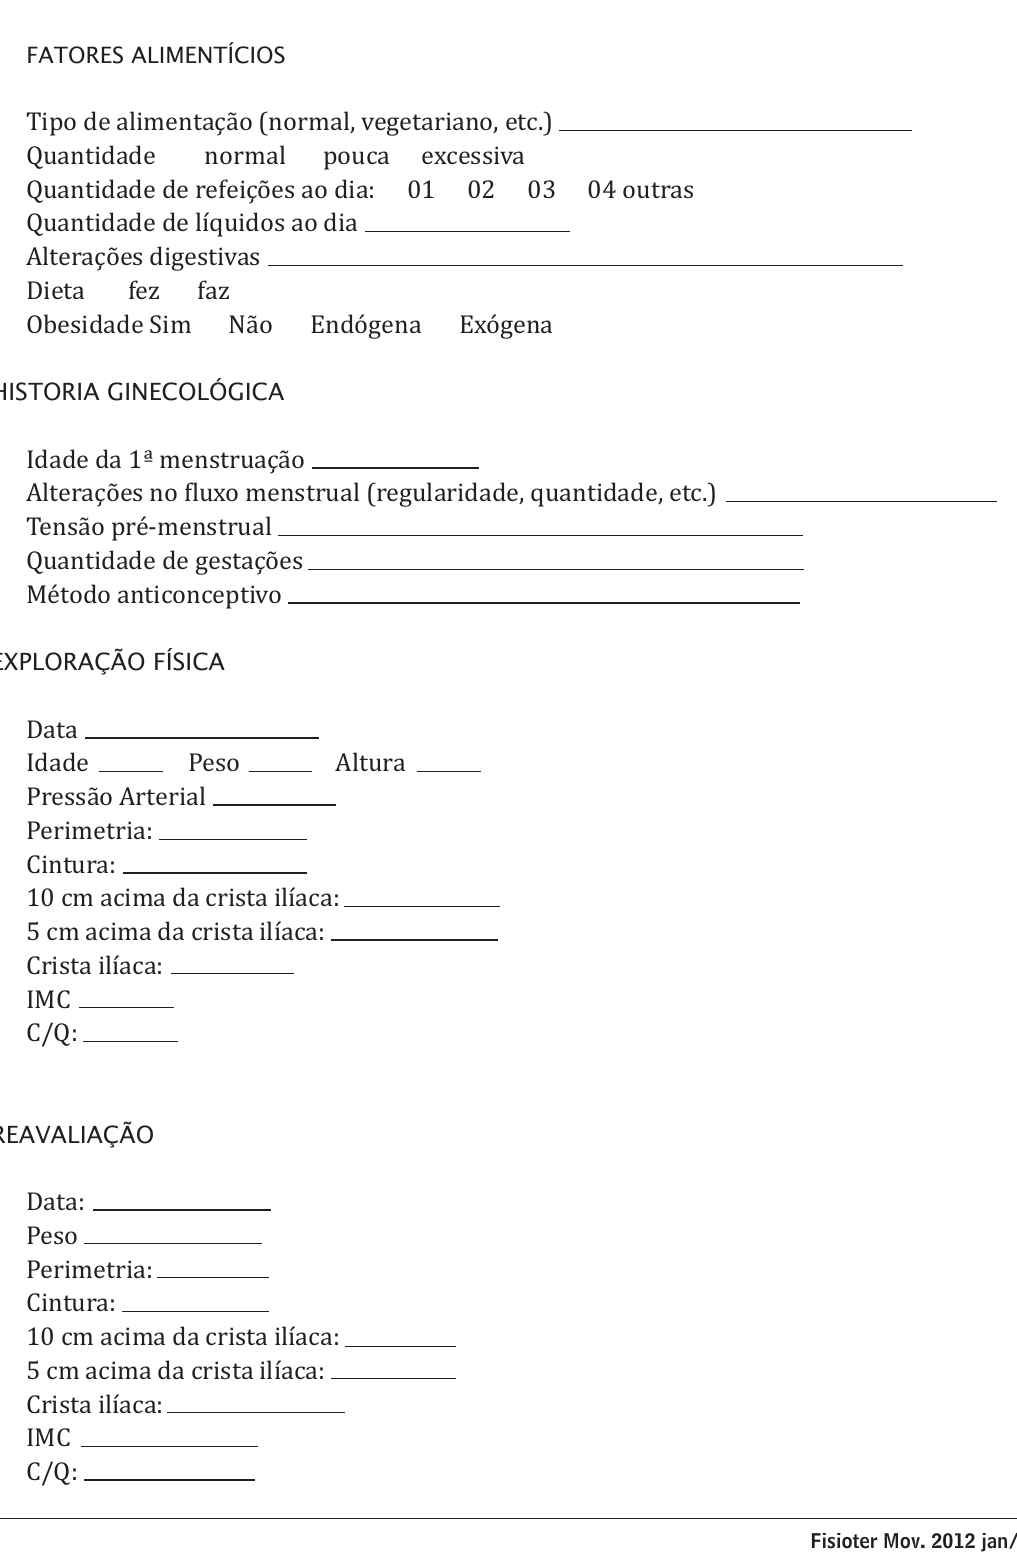
molipectomia (abdominoplastia) (cid:31) mamoplastia de redução (cid:31) rejuvenescimento facial (cid:31) mamoplastia de aumento (cid:31) lipoescultura (cid:31) mastectomia (cid:31) microcirurgia (cid:31) mentoplastia (cid:31) otoplastia/rinosseptoplastia